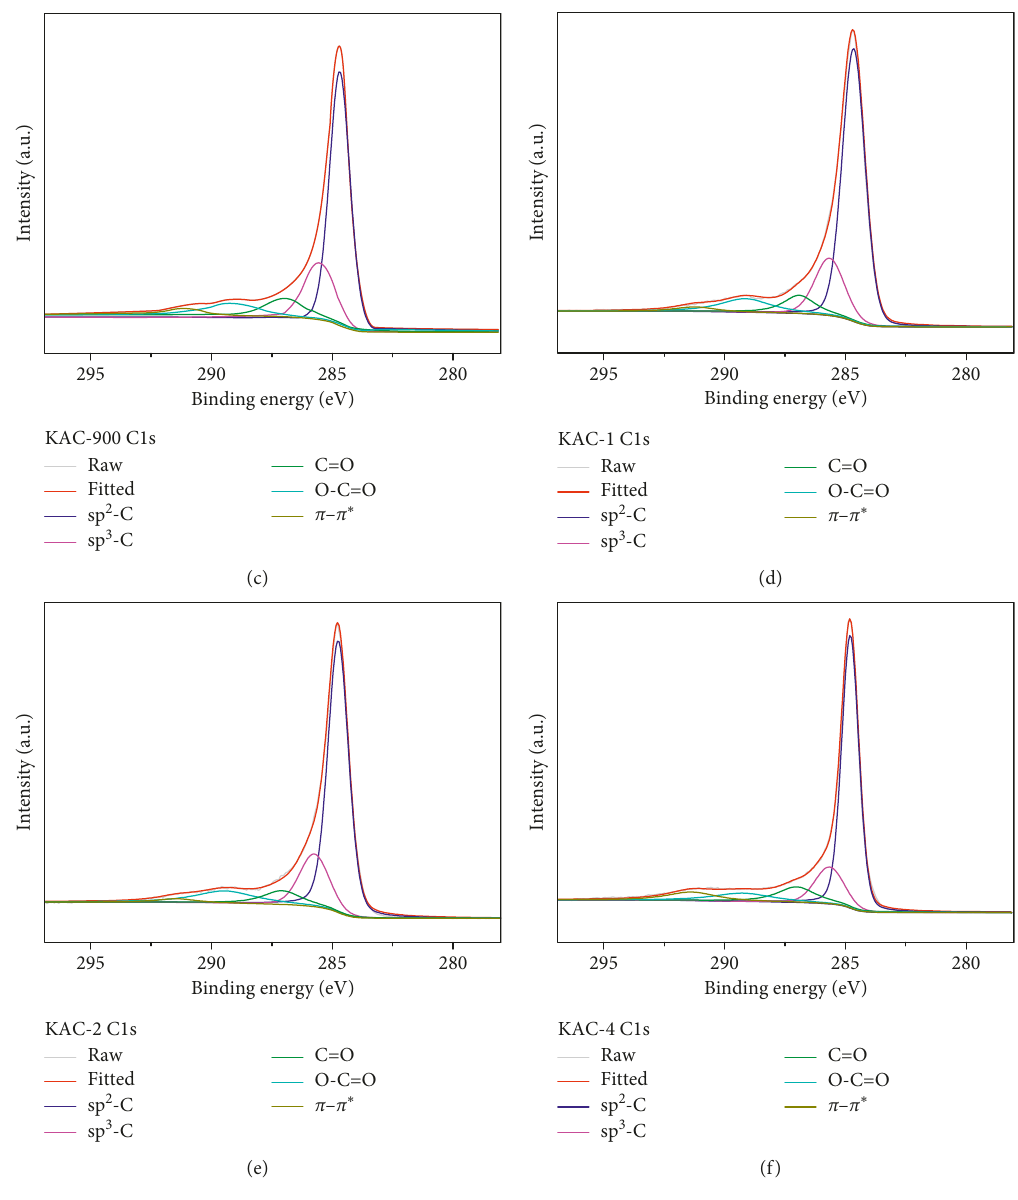
Figure 3: XPS C1s spectra of KAC-based